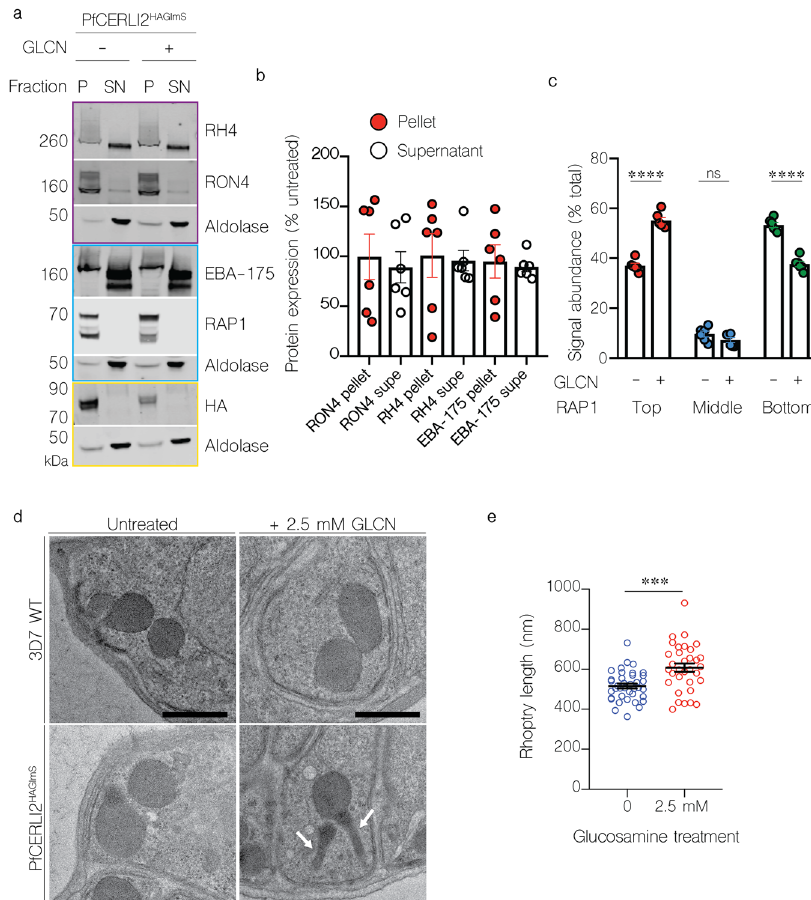
Fig. 6 Knockdown of PfCERLI2 inhibits rhoptry antigen processing, but not secretion, and is associated with rhoptry malformation. a PfCERLI2 HAGlmS ring-stage parasites were GLCN treated ( + ) or left untreated ( − ), before enzyme treatment of RBCs to prevent reinvasion. Lysates (P) and culture supernatants (SN) were harvested following schizont rupture and probed with antibody cocktails according to the colour theme: anti-RH4, anti-RON4 (rhoptry neck), anti-aldolase (loading control) antibodies (outlined in purple), anti-EBA-175 (microneme), anti-RAP1 (rhoptry bulb), anti-aldolase (loading control) antibodies (outlined in blue), anti-HA (PfCERLI2), anti-aldolase (loading control) antibodies (outlined in yellow). Representative blots of 5 biological replicates shown. b Western blots were normalised to the loading control, aldolase, and quanti fi ed, with results displayed as protein expression in GLCN treated sample as a percentage of the untreated signal. n = 5 biological replicates. c Quanti fi cation of individual band intensities, as a percentage